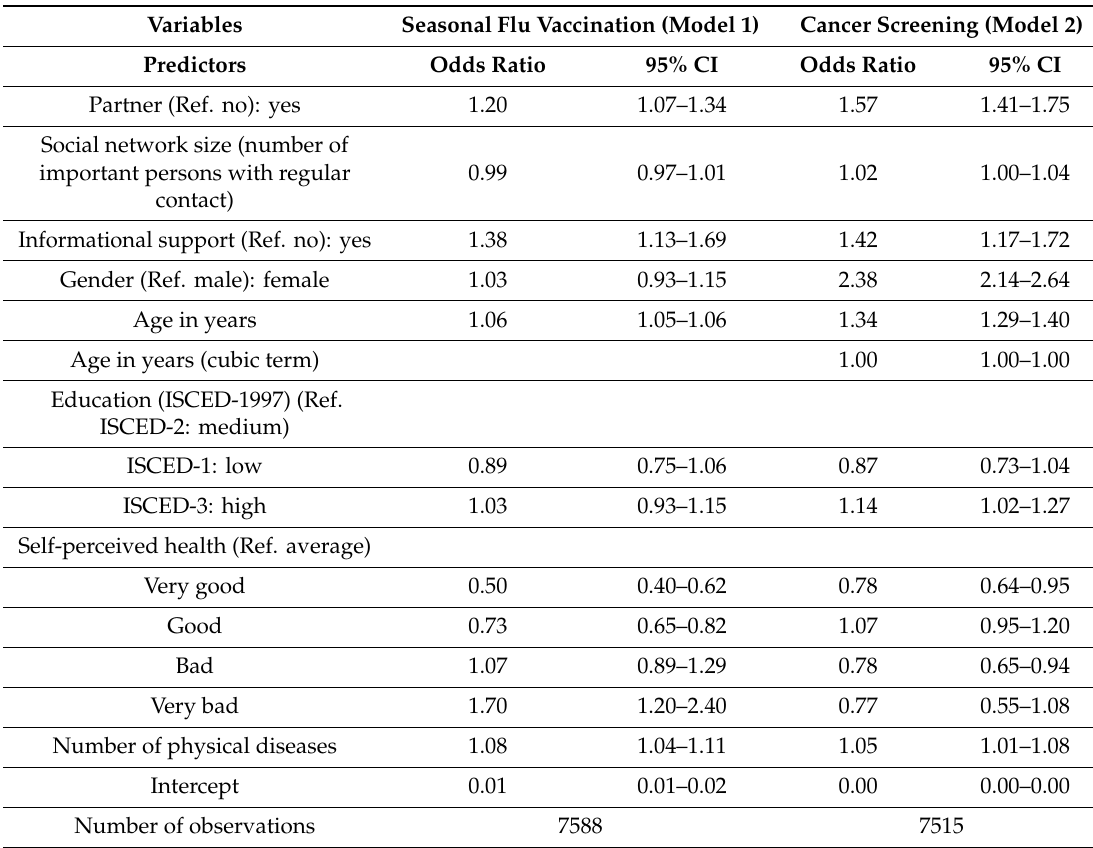
Table 2. Logistic regression models for flu vaccination (Model 1) and cancer screening (Model 2) (German Ageing Survey,